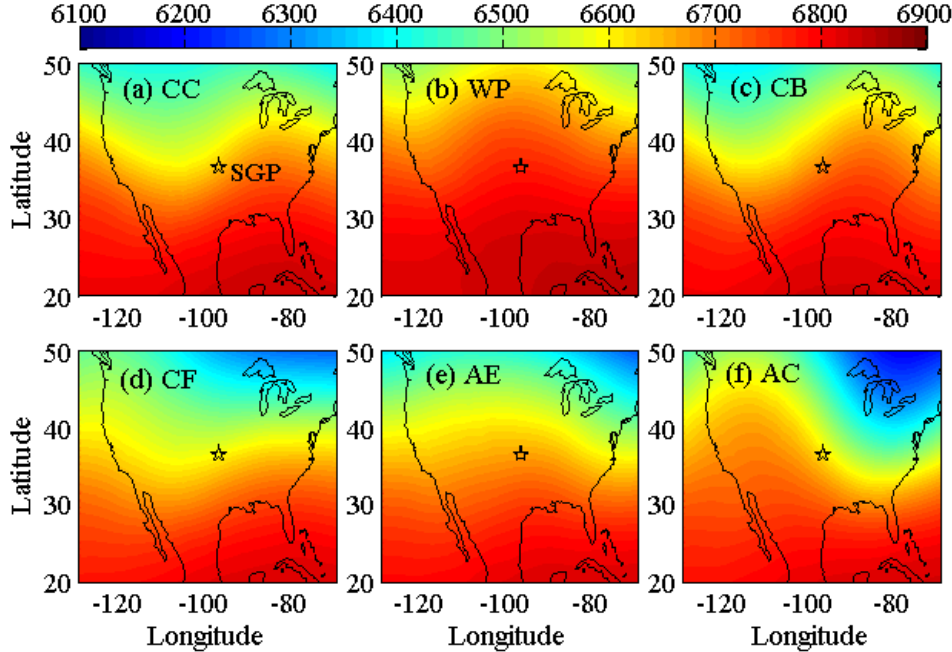
Figure 3. Geopotential height (units in m) at the 500-hPa pressure level derived from the daily NCEP NARR product averaged over 2001 to 2010 in the synoptic patterns of: CC ( a ); WP ( b ); CB ( c ); CF ( d ); AE ( e ); and AC ( f ) over the SGP site. The black star in each panel denotes the location of the SGP site.